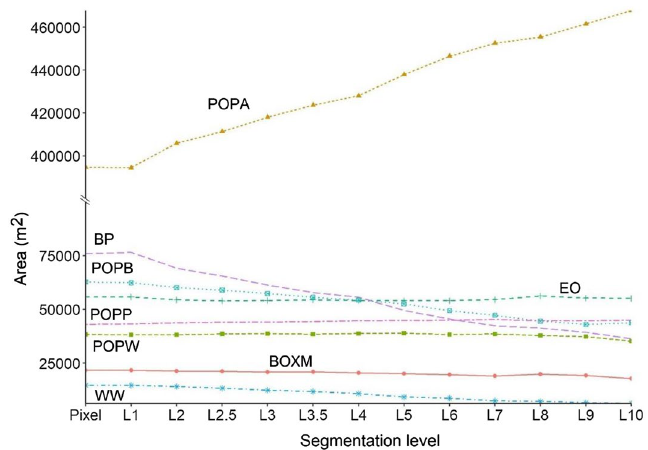
Figure 5. Area of tree species in the function of segmentation level. WW White willow, POPA Poplar (Agathe-F), BP Black pine, POPW White poplar, BOXM Boxelder maple, POPP Pannonia poplar, POPB Black poplar, EO English